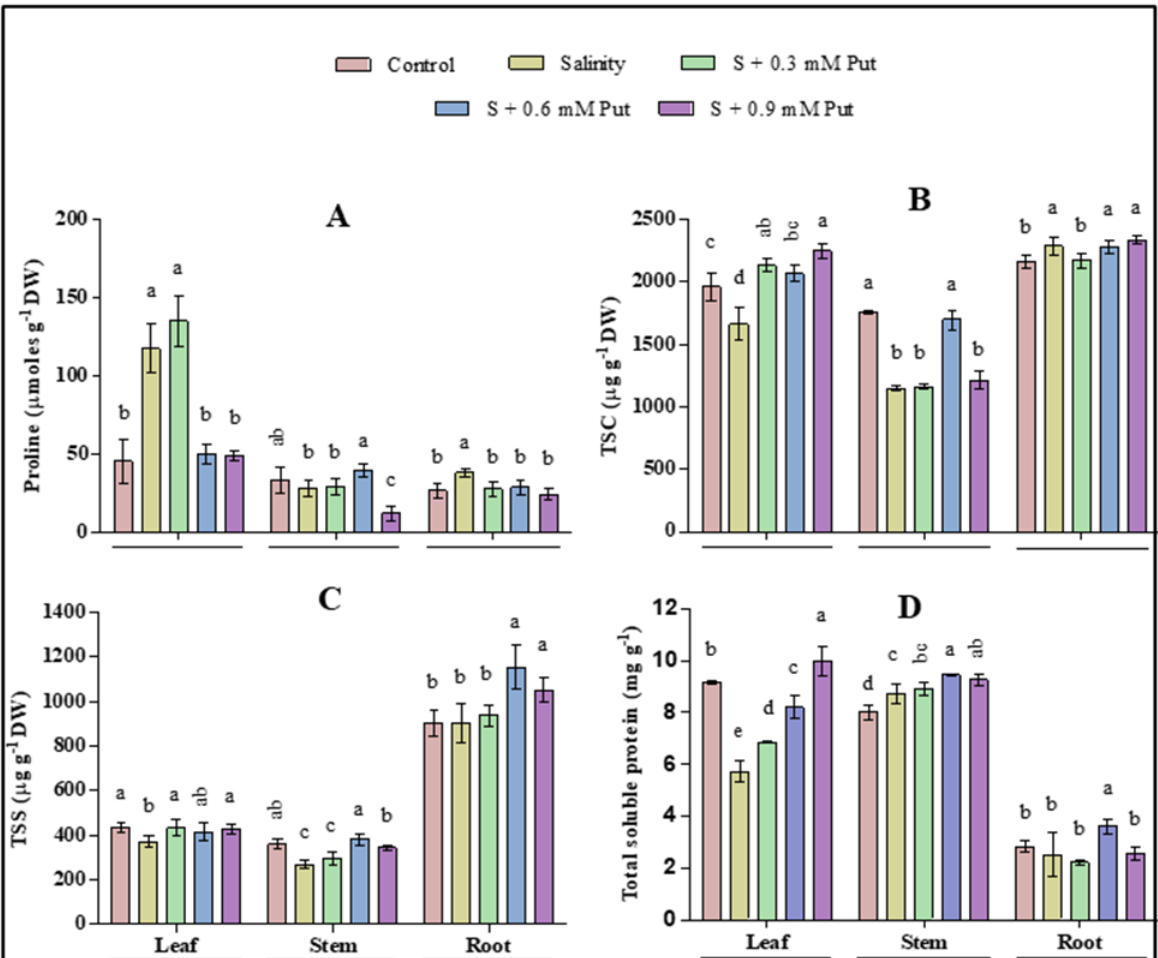
Figure 2. Effect of foliar application of putrescine on proline ( A ) Pro; total soluble carbohydrates ( B ), TSC; total soluble sugar ( C ), TSS; and total soluble protein ( D ), TSS of ginseng seedlings grown under salinity stress condition. Different letters indicate significant differences ( p ≤ 0.05) among the treatments within each parameter. Each value represents the mean ± SD ( n =